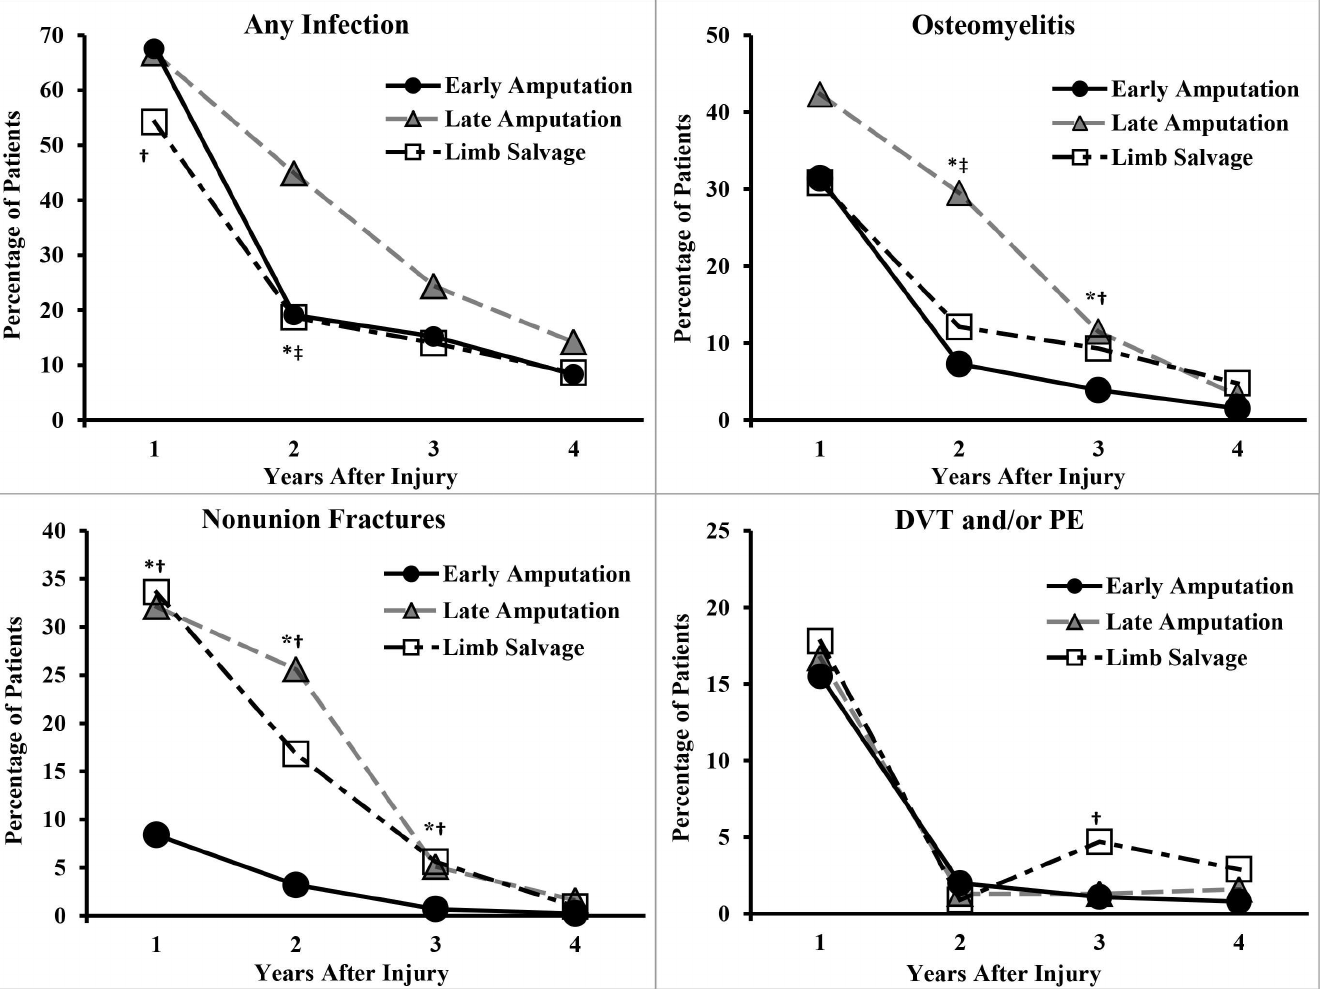
Fig 1. Prevalence of Selected Wound Complications by Time After Injury. Statistically significantdifference between groups, using chi-square or Fisher’s exact test as appropriate, p < 0.05 were * early amputation versus late amputation, †earlyamputation versus limb salvage,and ‡late amputation versus limb salvage.(Table 3 shows where injury group was significantly associatedwith outcomes after adjustingfor covariates). DVT = deep vessel thrombosis, PE =